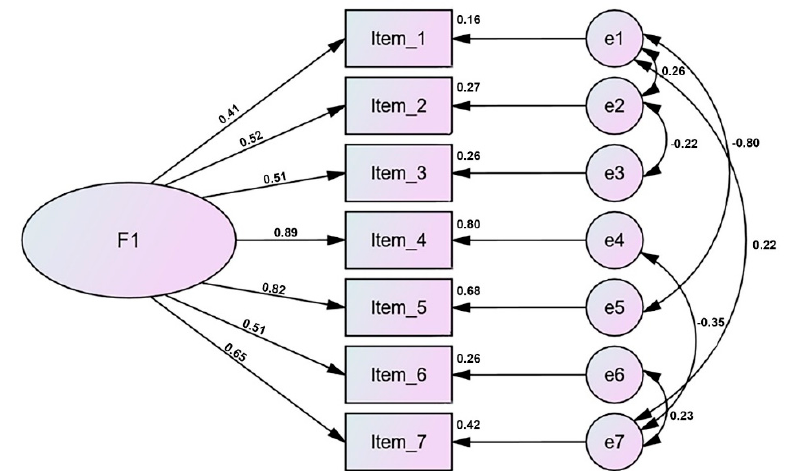
Figure 1. Factor Figure 1. Factor model.